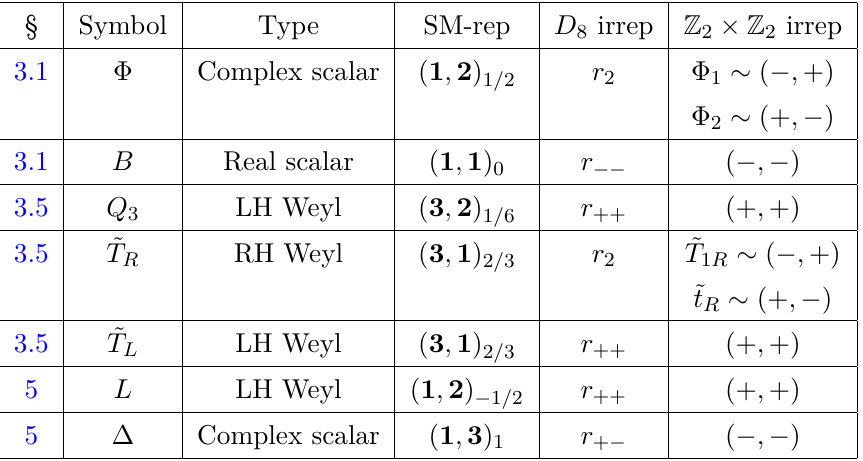
Table 1 . A summary of the fields introduced to our model and its applications. The fields below the double horizontal lines are of relevance to the neutrino model in section 5 only, and can otherwise be